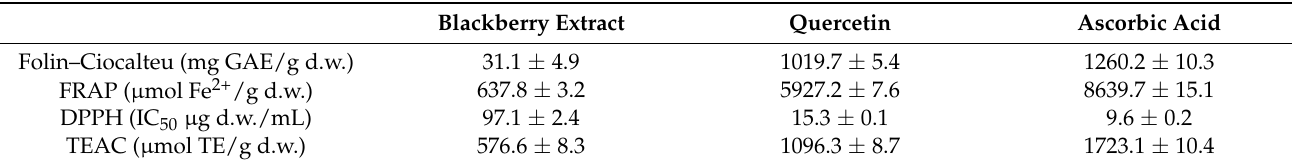
Table 3. Total antioxidants content, and antioxidant activity of blackberry extracts, quercetin and ascorbic acid (n =